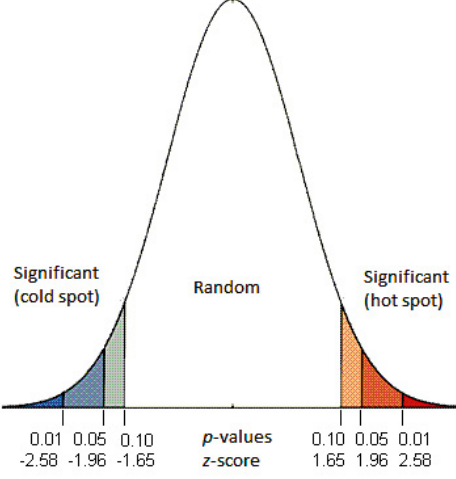
Figure 4. Gi* statistic distribution